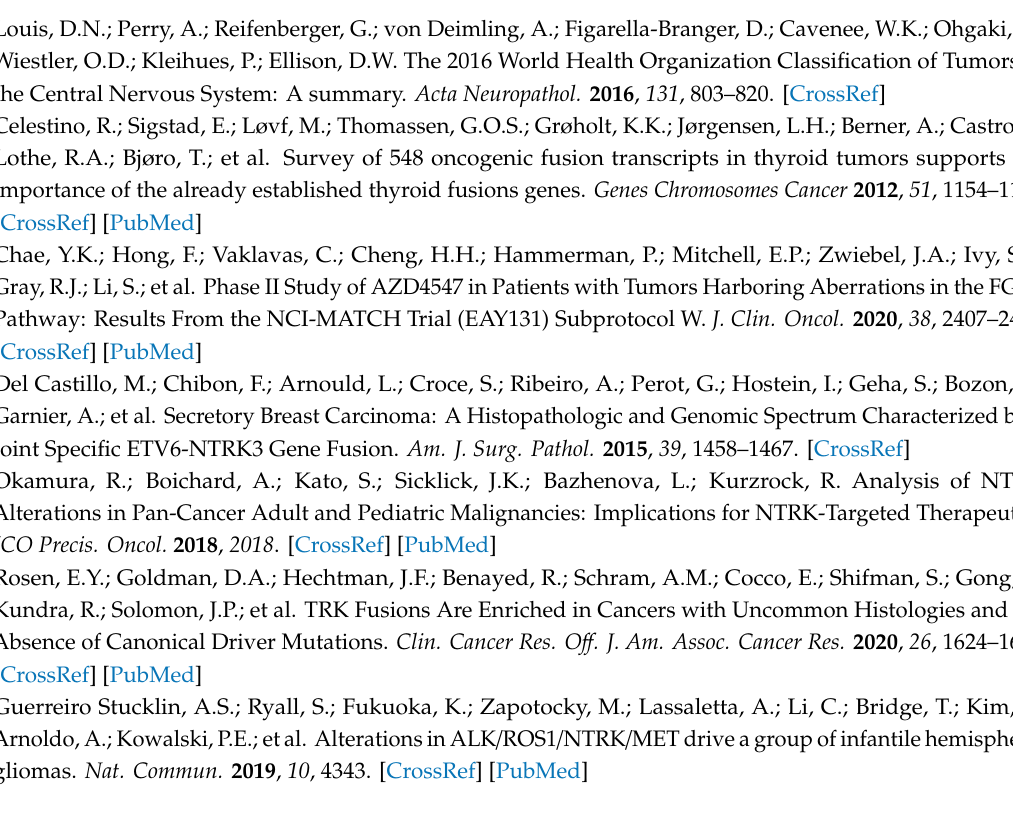
Figure S1: H&E and p53 IHC staining of the ROS1:ARCN1 fusion-positive infantile hemispheric glioma (200x), Figure S2: H&E and p53 IHC staining of the EML4:NTRK3 fusion-positive gliosarcoma (200 × ), Figure S3: CNV-plot in the ROS1:ARCN1 fusion-positive infantile hemispheric glioma as determined by methylation array of tumor tissue, Figure S4: CNV-plot in the EML4:NTRK3 fusion-positive gliosarcoma as determined by methylation array of tumor